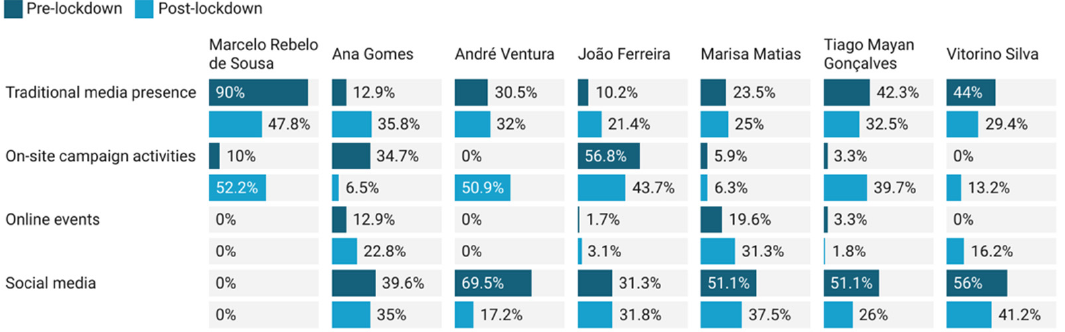
Figure A2. Lockdown effect. Relative importance of different campaign efforts before and after the declaration of lockdown by candidate (2021 election). Source: Own data (see Section 3.1.1).